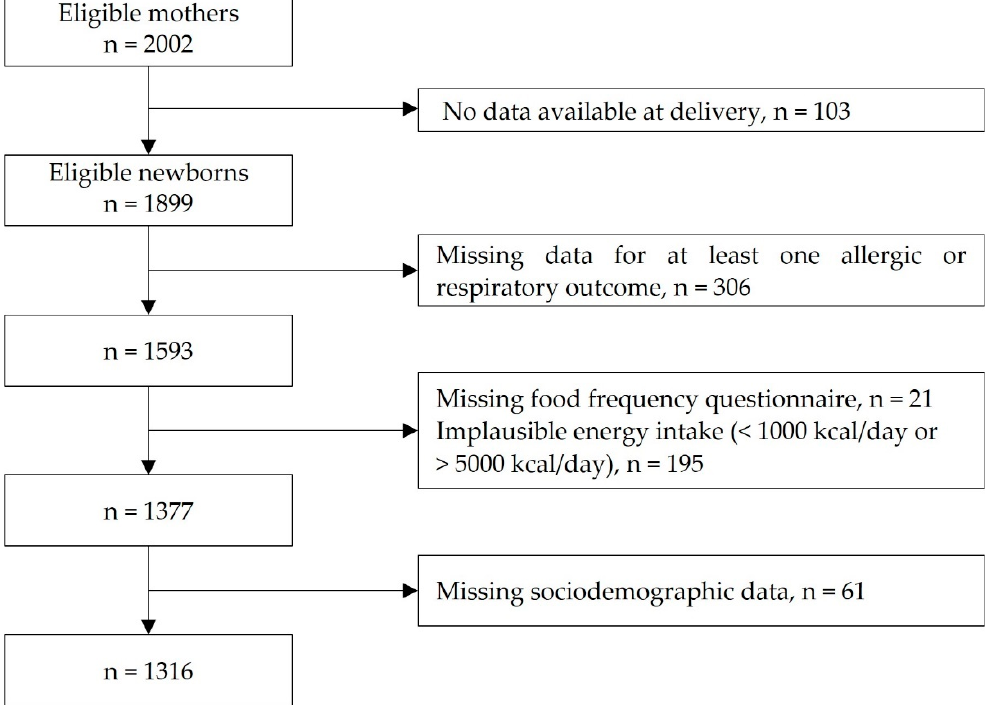
Figure 1. Flowchart of the study population.